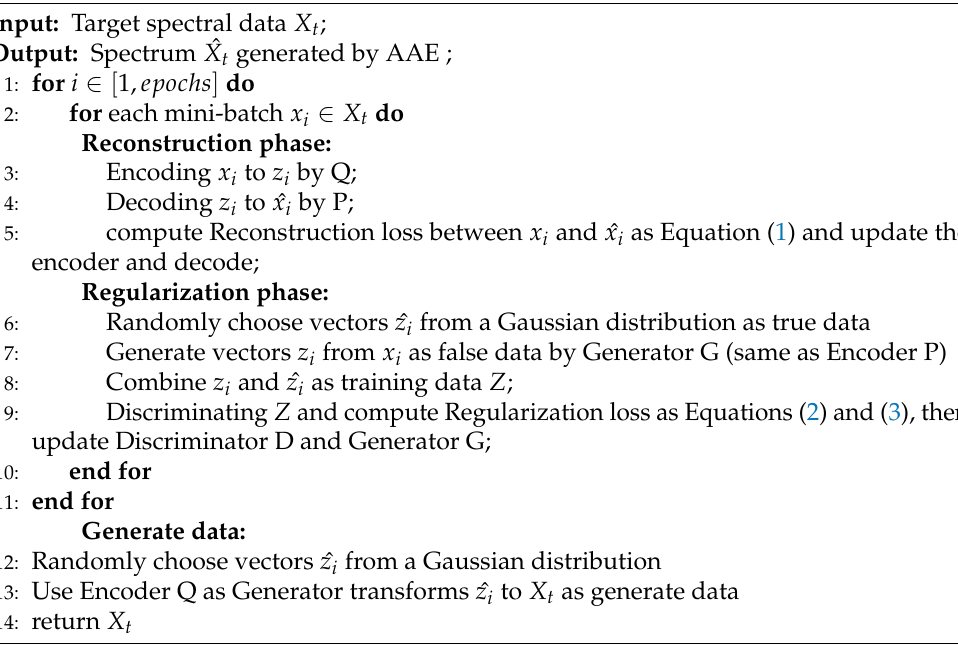
Algorithm 1 Adversarial AutoEncoder Training